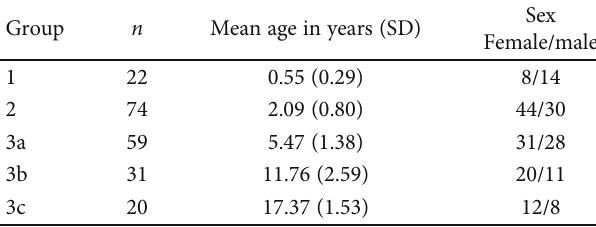
Table 1: The detailed characteristic of groups of European bison used in the